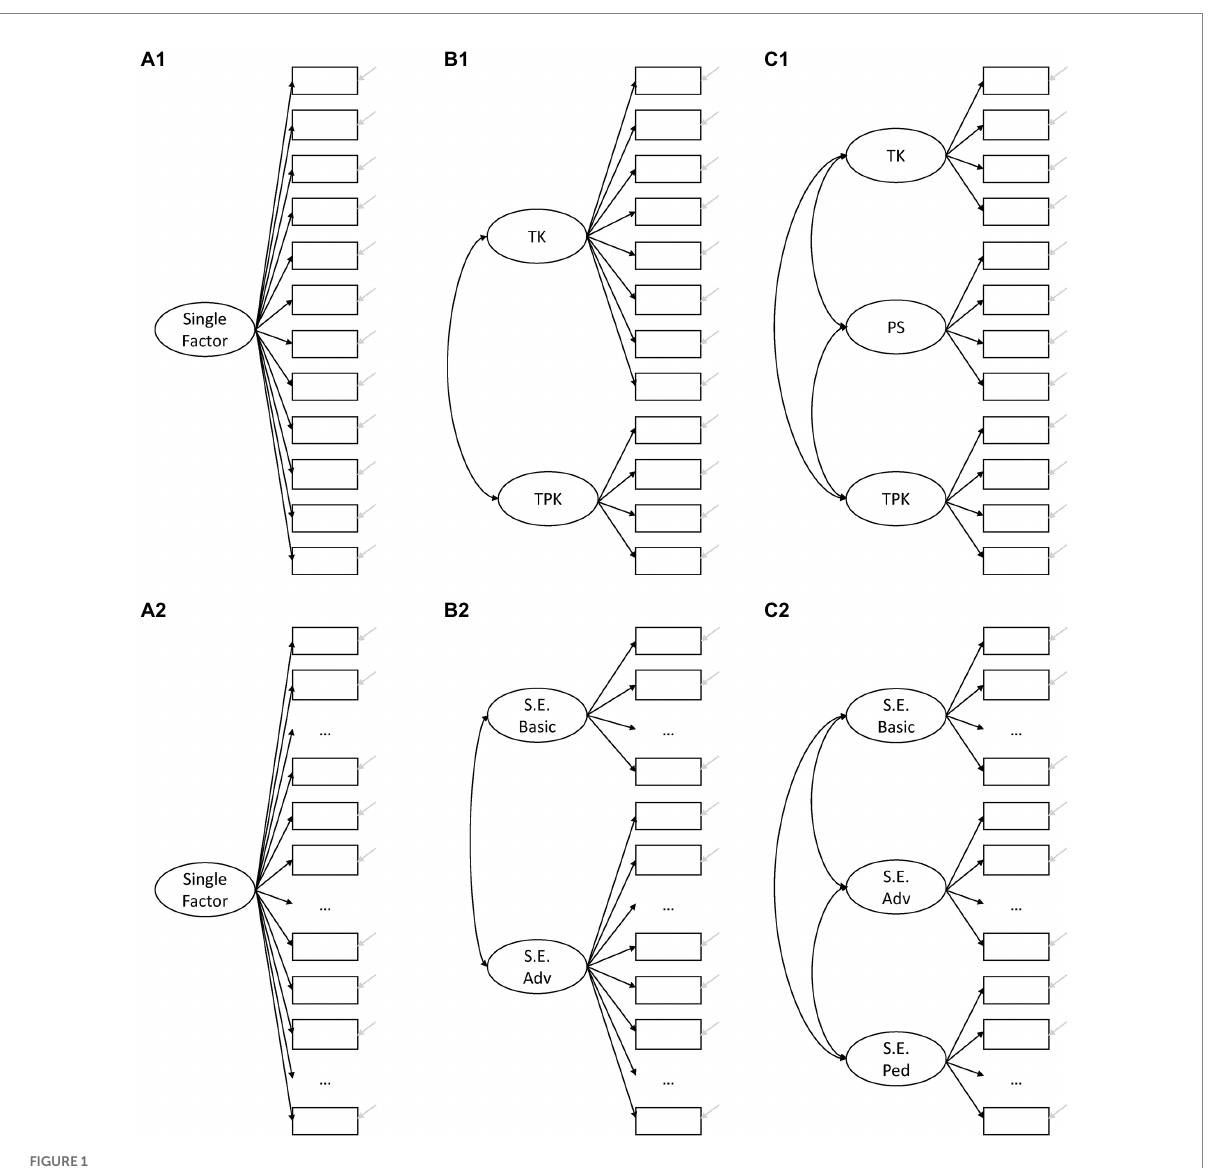
FIGURE 1 Different models of the TPACK items (A1–C1) and the self-efficacy items (A2–C2)